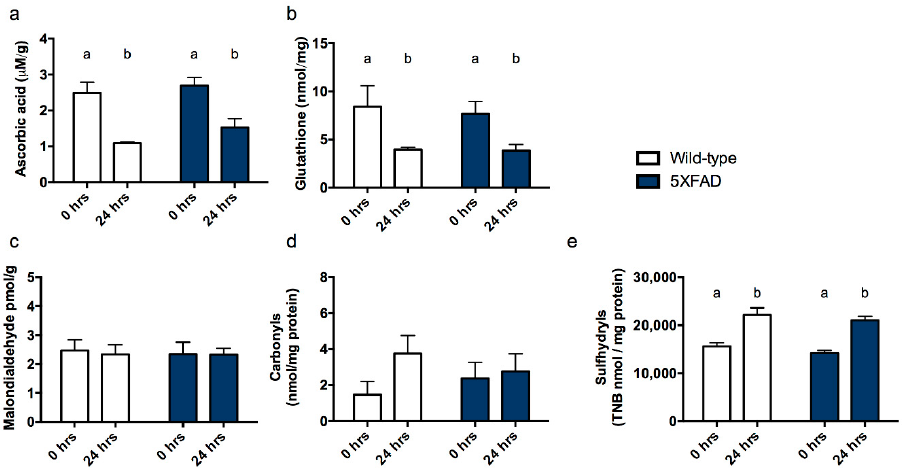
Figure 3. Antioxidant and oxidative stress markers in cortex of 5XFAD mice and wild-type littermate controls. ( a ) Ascorbic acid, ( b ) total glutathione, ( c ) malondialdehyde, ( d ) protein carbonyls and ( e ) sulfhydryl measurements from cortex at 0 h and 24 h following sacrifice (post mortem interval, PMI). Differing letters signify a main effect of PMI. Bars that do not share a letter differ from other cases within the same group at p <